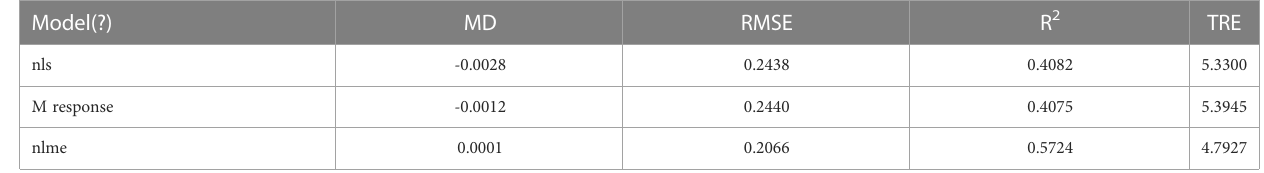
TABLE 6 Statistical indicators of different forms of CW models using LOOCV methods (OLS-Eq.18; M-response-Eq.19; NLME-Eq.19). Model(?)